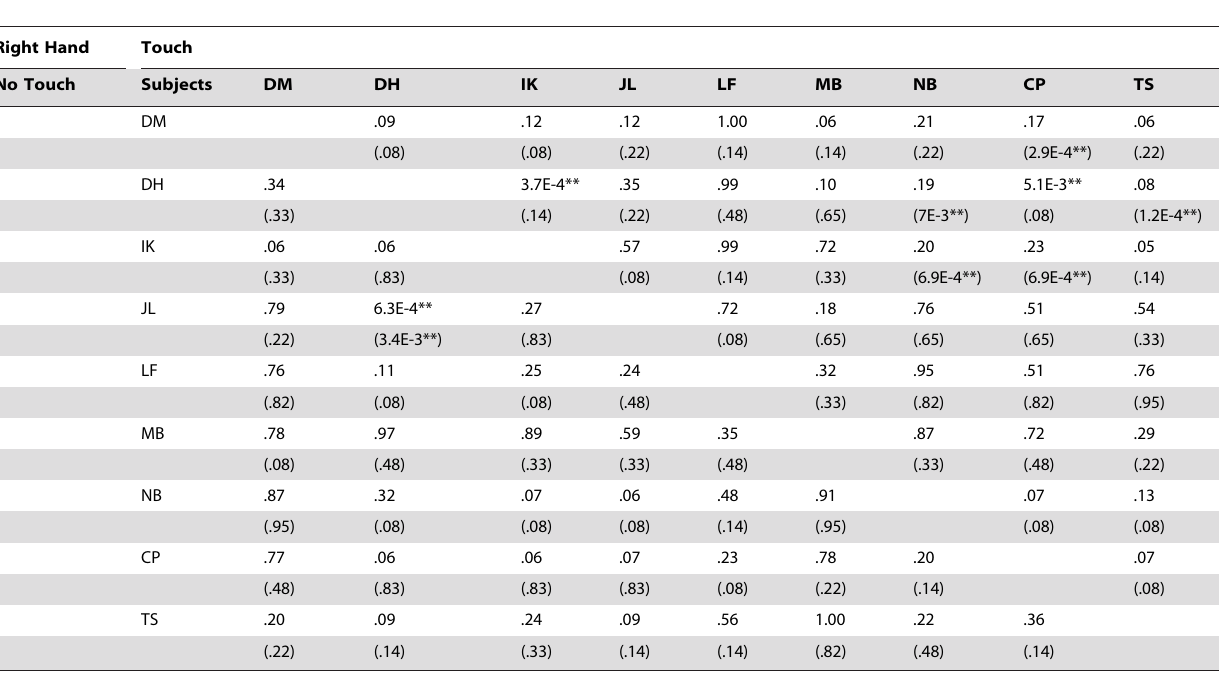
Table 4. Test of Similarity Between Subjects for the Right hand: Resulting p-values from the K-S test.